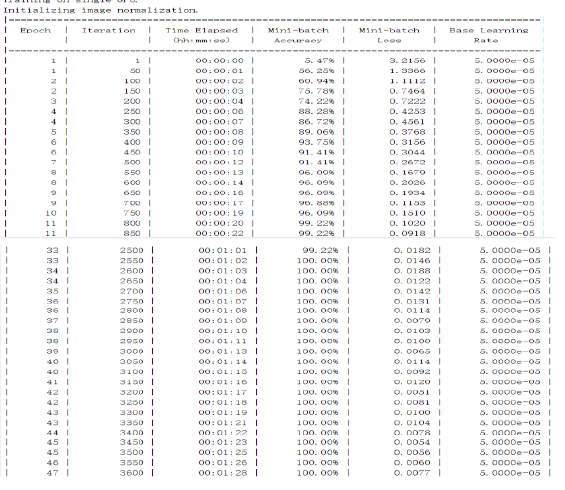
Figure 10 . Training model test results.